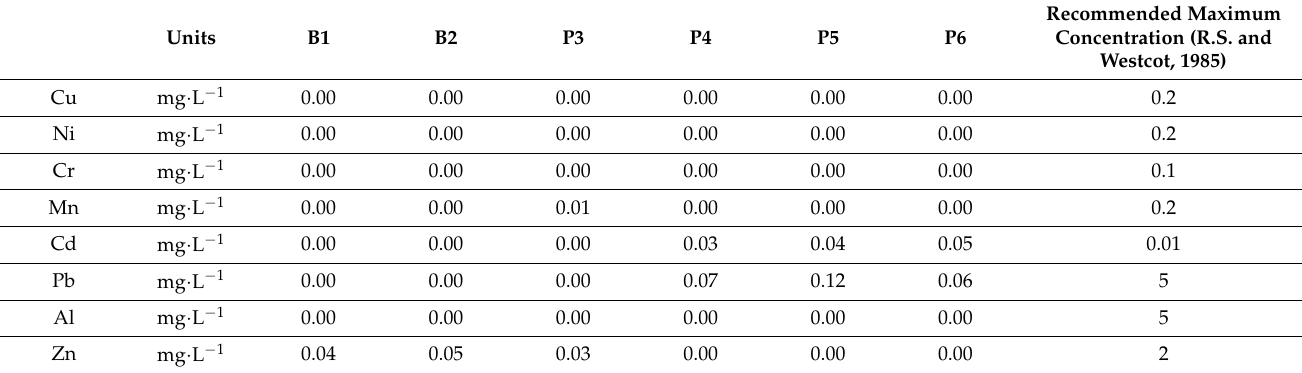
Table 8. Metallic trace elements in